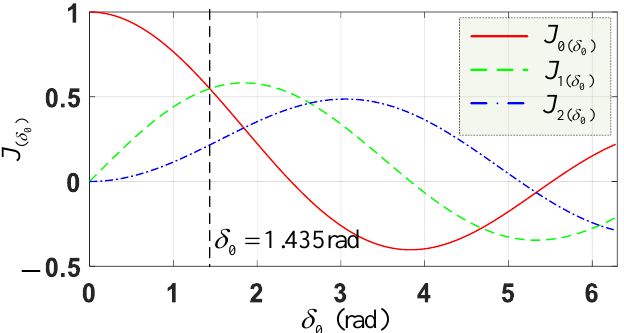
Figure 2. Bessel series variation in accordance with PEM phase modulation amplitude.